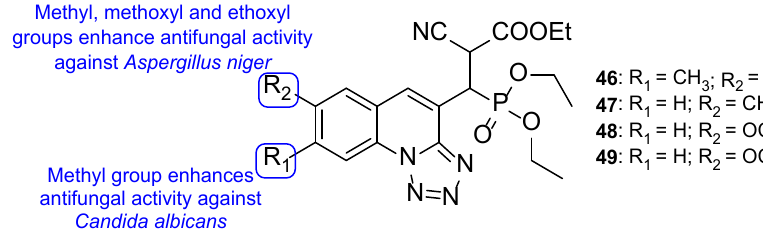
Figure 25. Chemical structures for compounds 46 – 49 and SAR [105]. Nikam et al. synthesized chalcone, pyrazoline, and isoxazoline hybrids with tetrazole moieties and tested their antifungal activity against C. albicans and A. niger using the agar dilution method and fluconazole as standard. All tested compounds displayed moderate antifungal activity when compared to fluconazole (MIC values of 82 µM against both strains). Compounds 50a , 51a , 51b , 52a , 52b , and 52c (Figure 26) presented similar values of MIC to the reference drug (MIC = 82 µM) against C. albicans and compounds 50a , 51c , and 52c (Figure 26) displayed equal values of MIC to standard (MIC = 82 µM) against A. niger , making them promising structures for antifungal activity [106].